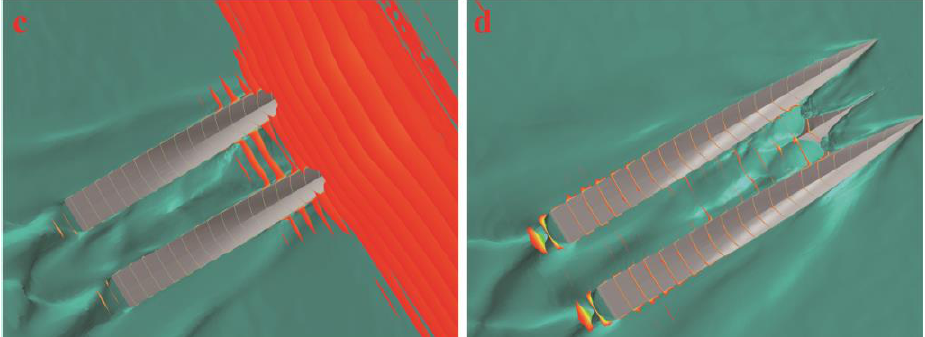
Figure 29. Boundary layer represented by slices colored with dimensionless axial velocity limited to U x /U 0 = 0.9 at 5 level sea state with the 0° wave direction. ( a ) T = 1/4 T 0; ( b ) T = 2/4 T 0; ( c ) T = 3/4 T 0; ( d ) T = 4/4 T 0.